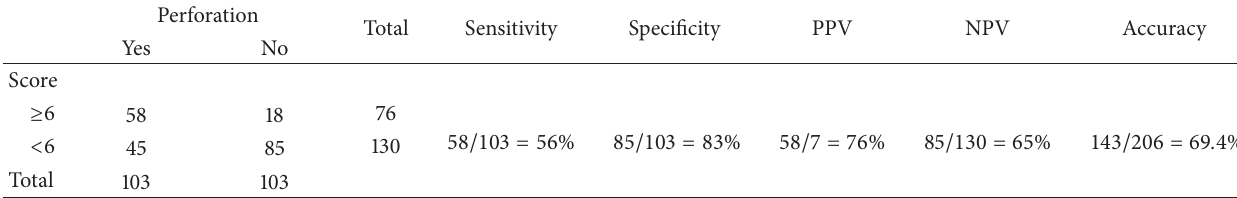
Table 7: Validation scores for predicting ruptured